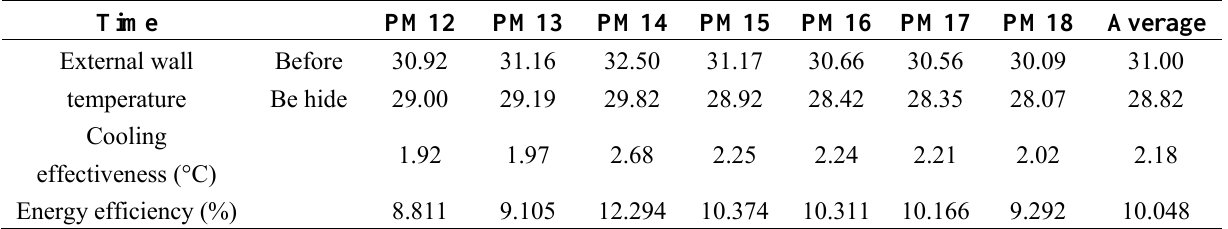
Table 5. Value of the temperature tested (measurement date: 25 June 2012).